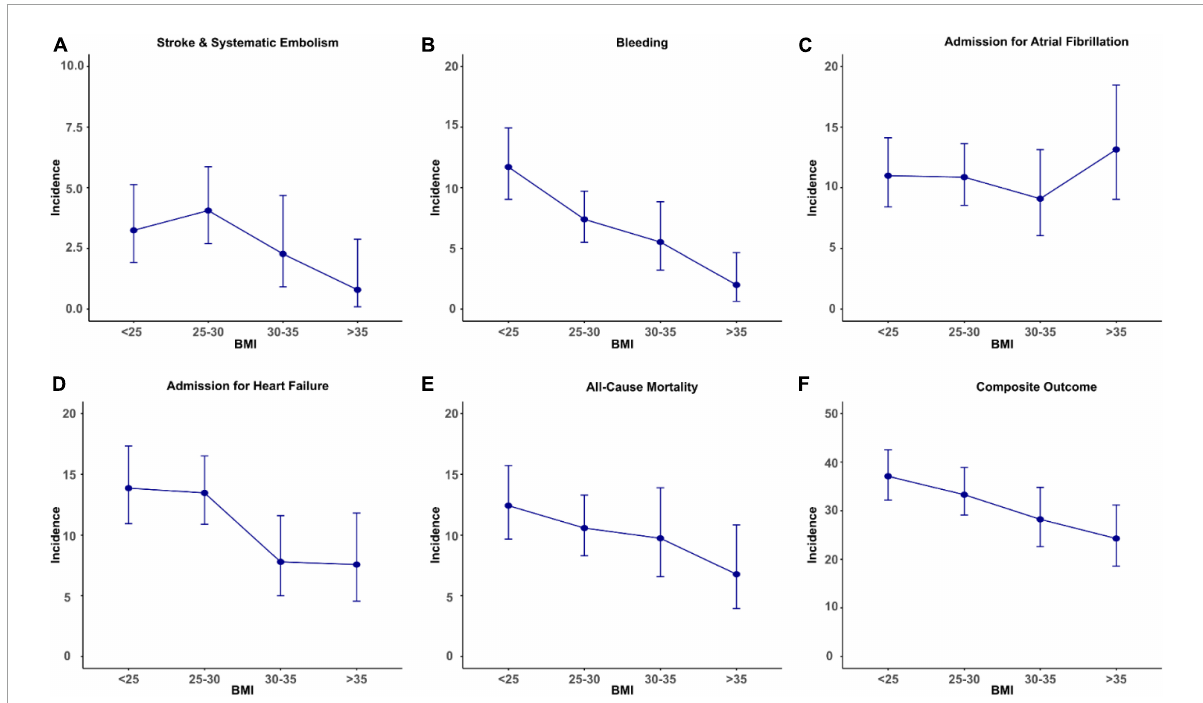
FIGURE1 Body mass index and incident rates of clinical outcomes [ (A) stroke and systematic embolism; (B) bleeding; (C) admission for atrial fibrillation; (D) admission for heart failure; (E) all-cause mortality; (F) composite outcome] per 100 patient-years. The bar represents confidence interval of incident rate.